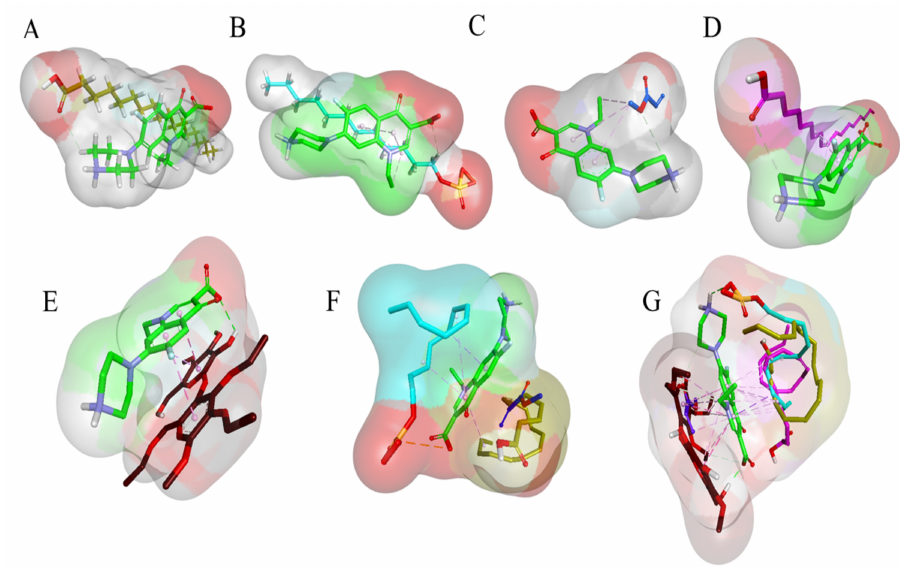
Figure 11. Structure of polymer and drug complex. ( A ). 3D surface and structure representation of Stearic Acid-NOR complex, ( B ). 3D surface and structure representation of SLS-NOR complex, ( C ). 3D surface and structure representation of Eudragit-NOR complex, ( D ). 3D surface and structure representation of Oleic Acid-NOR complex structure, ( E ). 3D surface and structure representation of Ethyl Cellulose-NOR complex structure, ( F ). 3D surface and structure representation of Stearic Acid-Eudragit-SLS-NOR complex, ( G ). 3D surface and structure representation of Stearic Acid-Eudragit-SLS- OA-EC-NOR complex